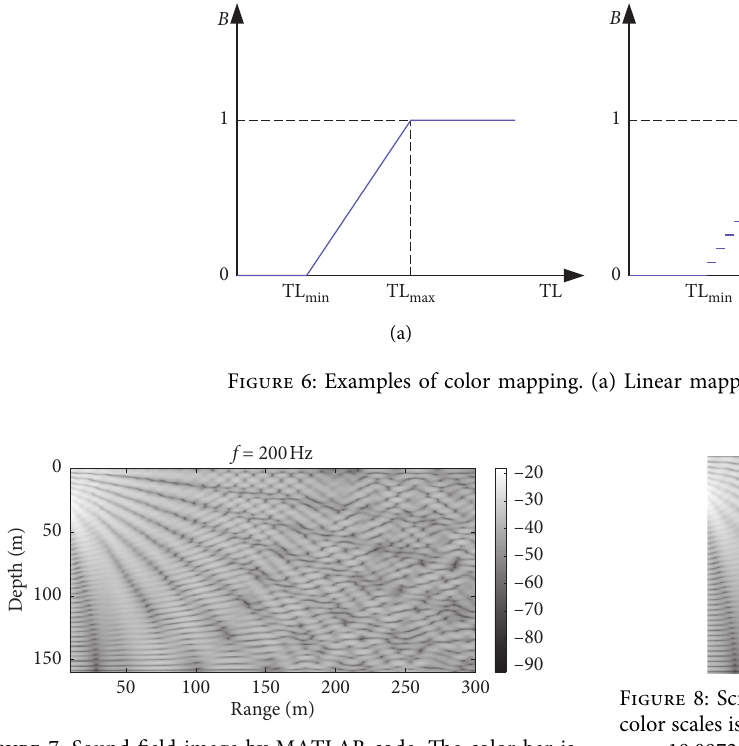
Figure 7: Sound field image by MATLAB code. The color bar is “gray” in MATLAB.